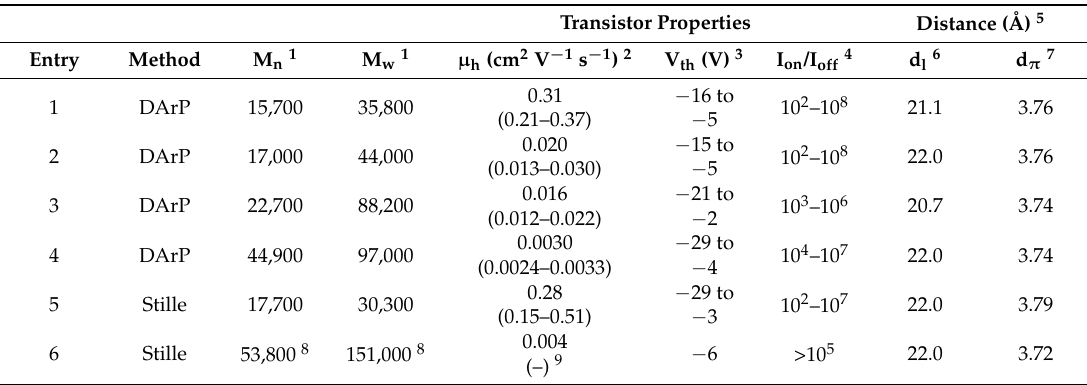
Table 3. OFET characteristics and ordering parameters for poly( 1 - alt - 2